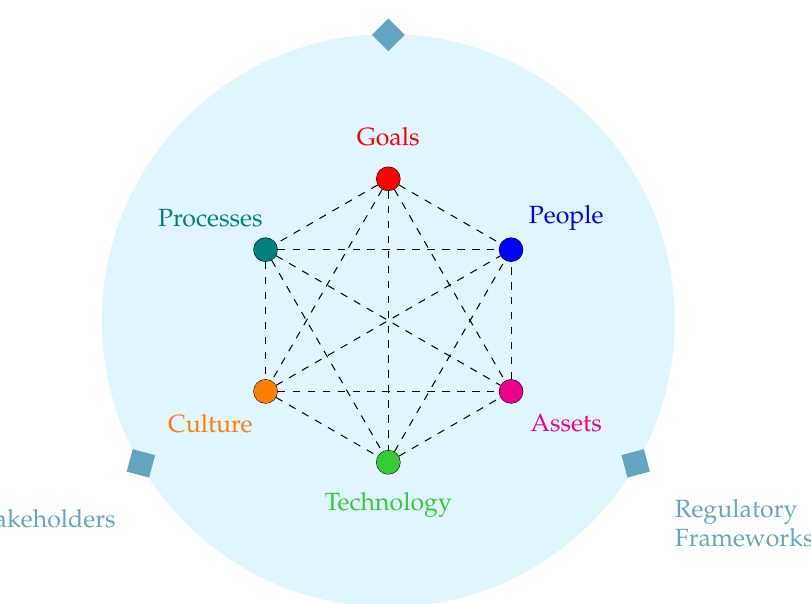
Figure 3. A socio-technical system embedded within an external environment, based on Davis et al.